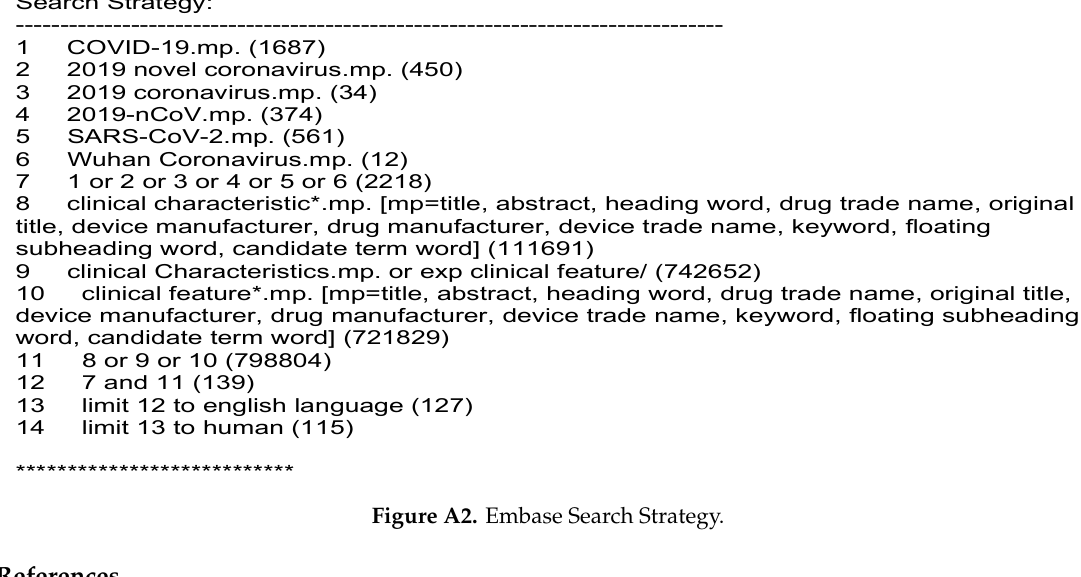
Figure A1. Medline Search Strategy.